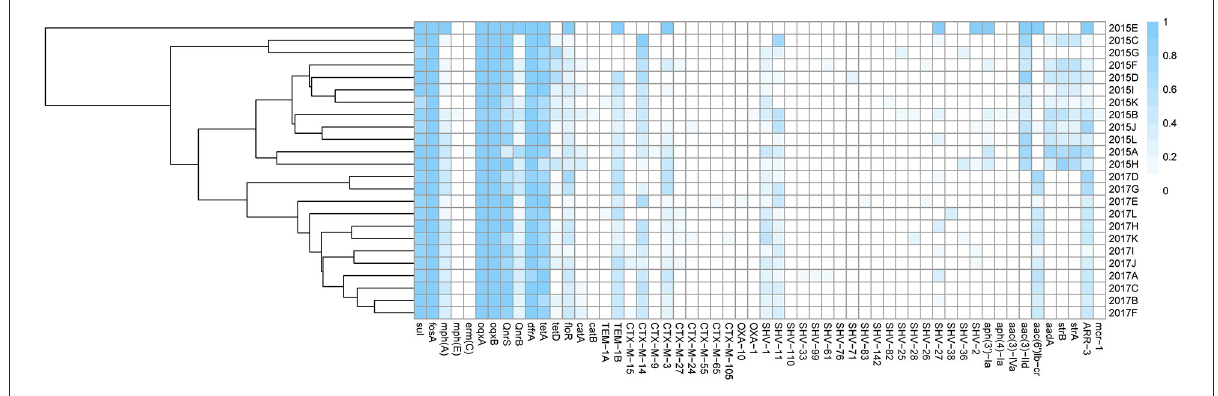
FIGURE7 Distribution of phylogenetic group, AMR among ESBL-KP isolates from 12 villages in Shandong Province, China. The color of each box represents the percentage of the resistant gene among sequenced isolates in the corresponding village of the 2 years.